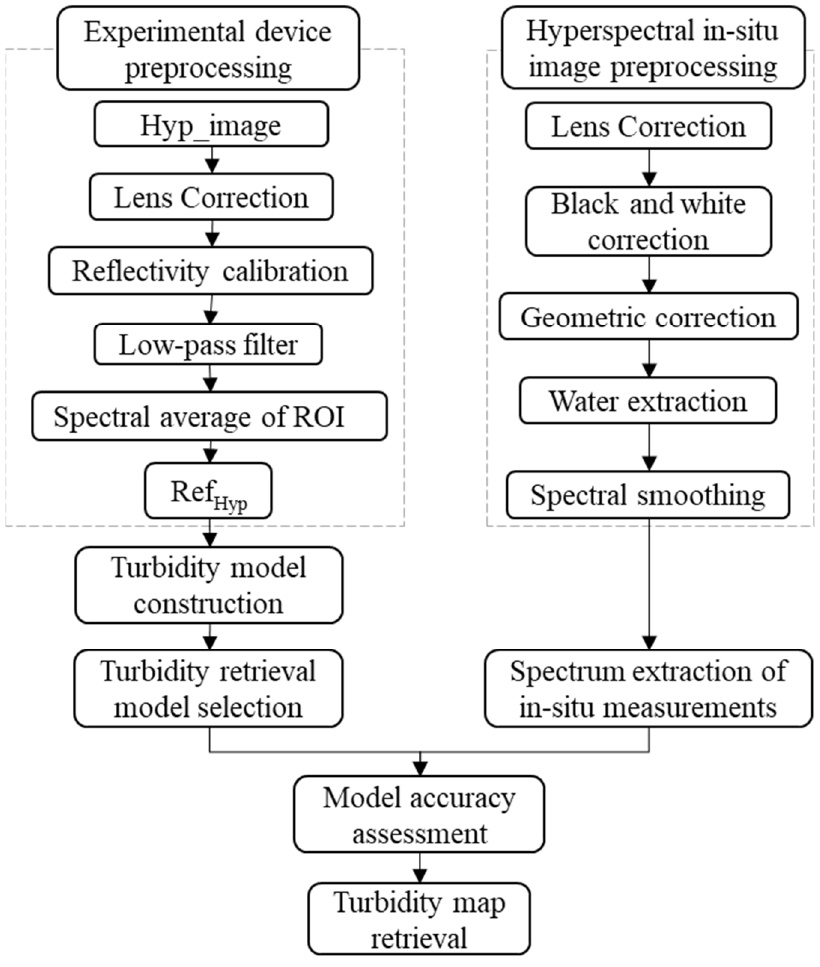
Figure 3. Flow chart of turbidity model construction and validation.